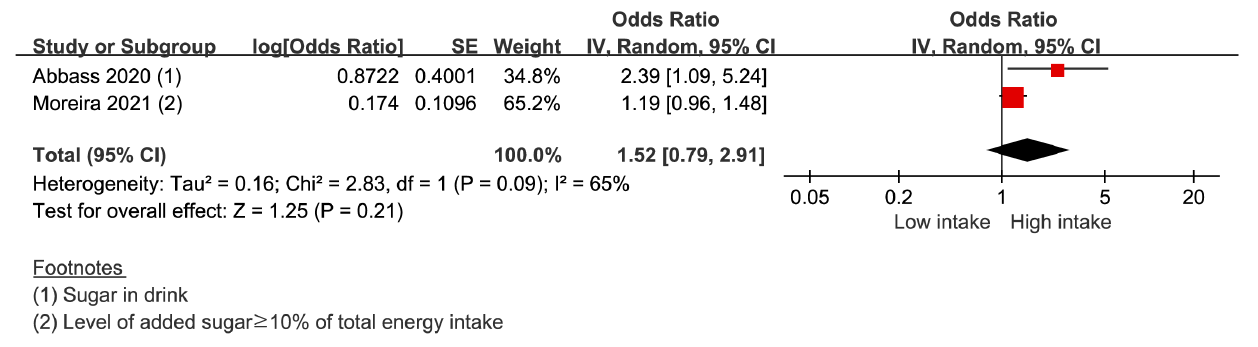
Figure 4. Risk of periodontal disease with the high-sugar diet [26,30]. -red color: weight for overall effect; -black color: 95% confidence interval